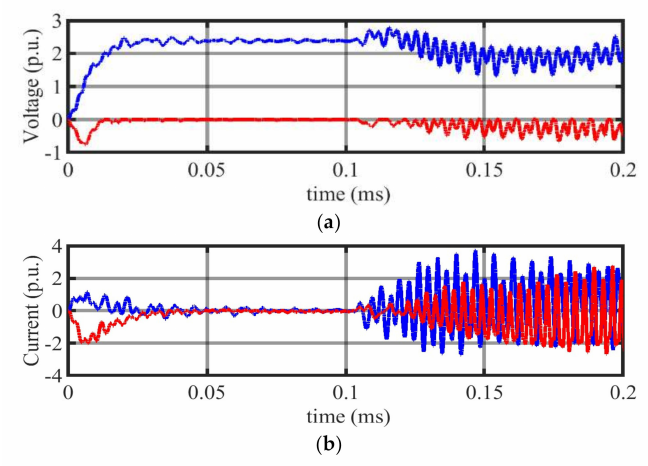
Figure 25. ( a ) DC Voltage and ( b ) DC current measured under NPG fault occurred 200 km from RS-I Line 1.